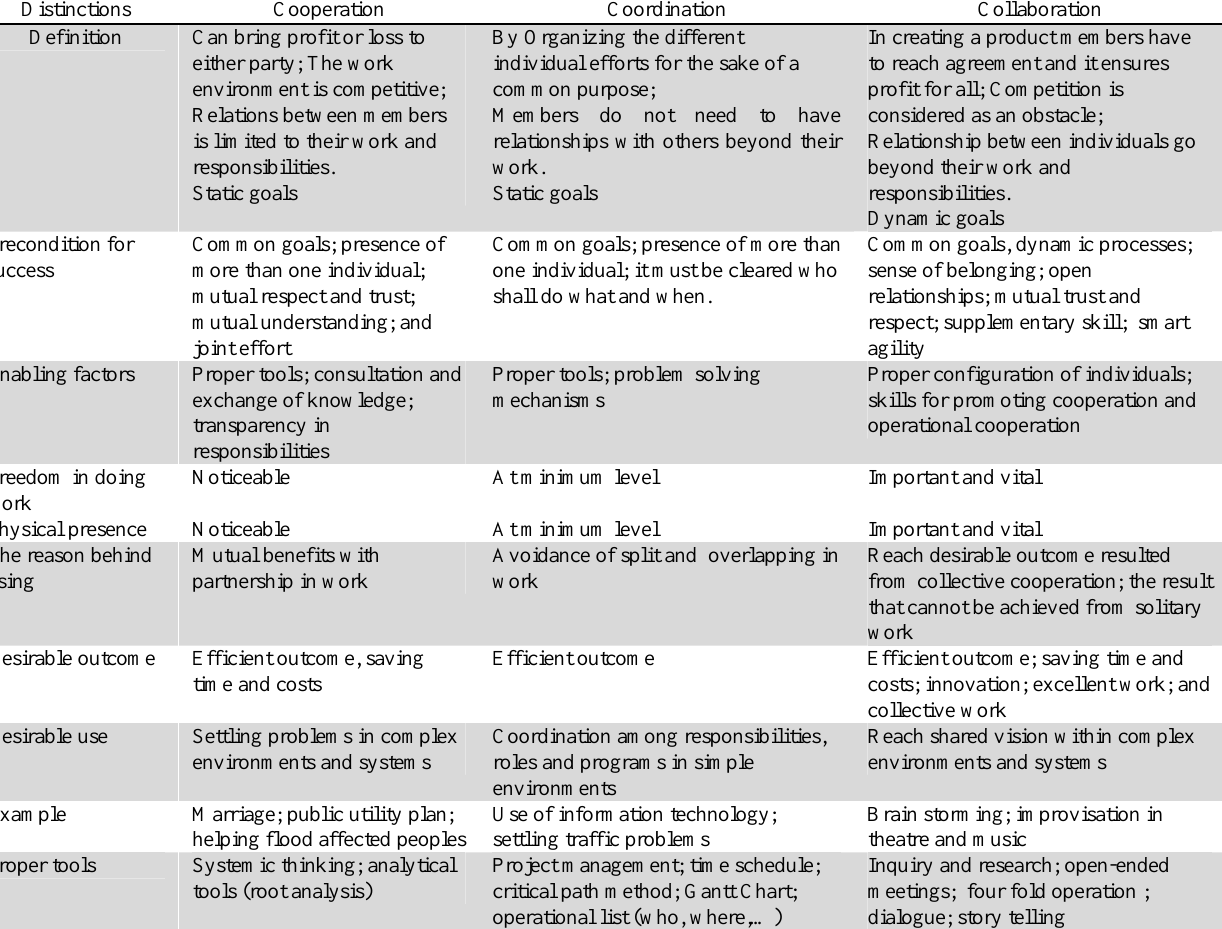
Comparison between distinctions of coordination, cooperation & collaboration (Kenney, 2012)